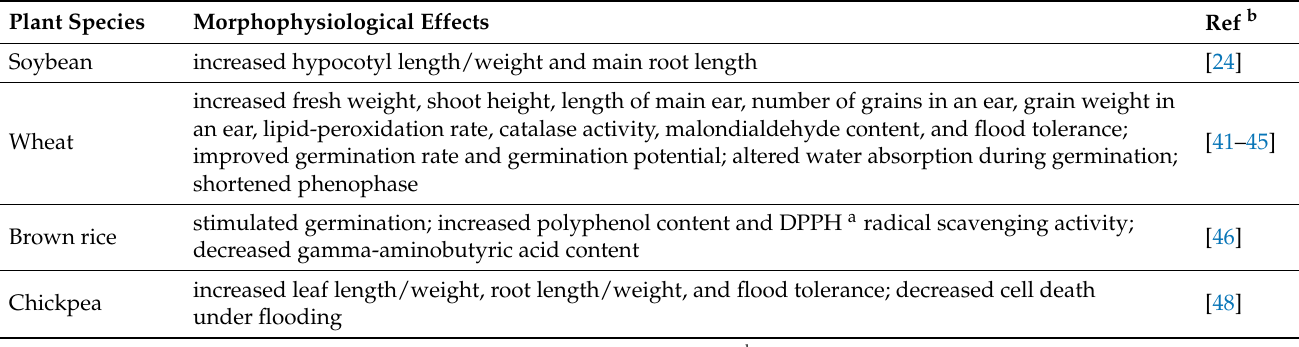
Table 2. Morphophysiological effects of millimeter-wave irradiation on